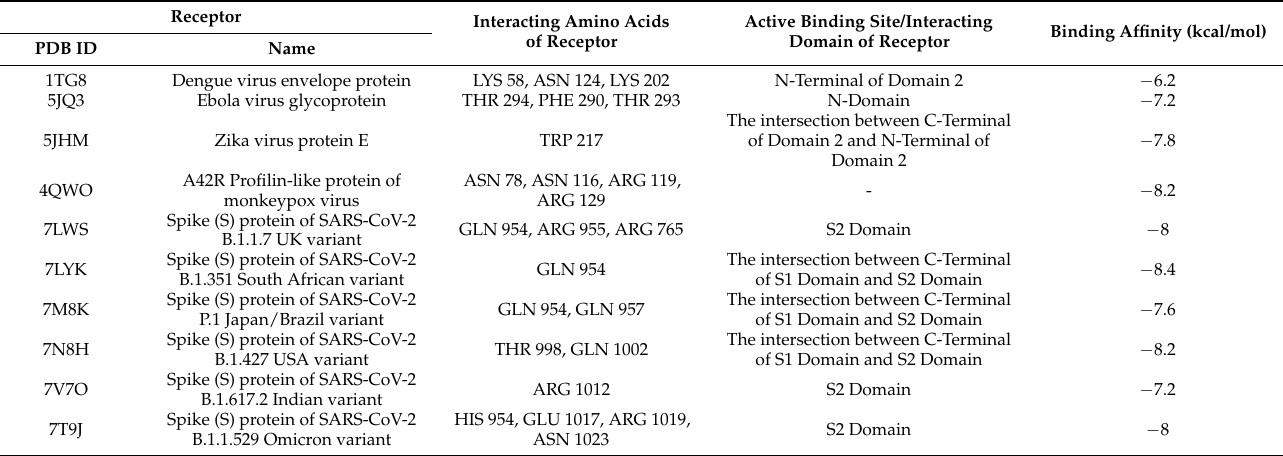
Table 9. Molecular docking analysis of silvestrol (CID: 11787114) derived from Aglaia spp. Receptor Interacting Amino Acids Active Binding Site/Interacting Binding Affinity (kcal/mol) of Receptor Domain of Receptor PDB ID